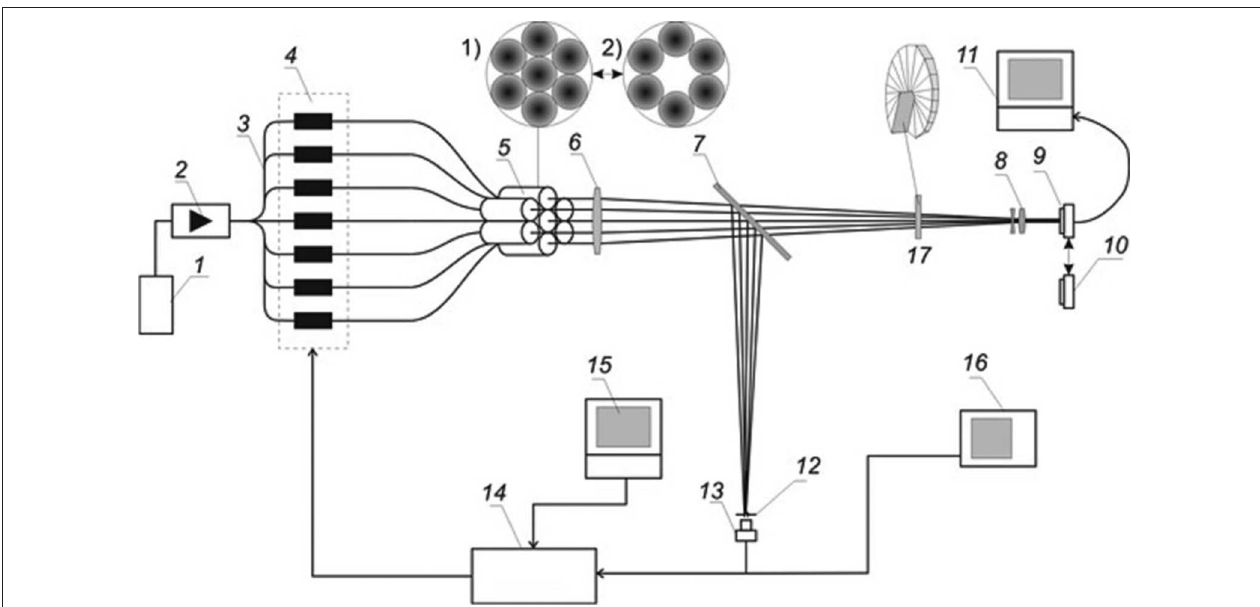
FIGURE 6 | Diagram of the experimental setup: narrowband laser (1) , optical fiber amplifier (2) , fiber splitter (3) , phase modulators (4) , fiber collimators (5) , long-focus lens (6) , beam splitting plate (7) , lenslet (8) , beam profiler (9) , Shack–Hartmann sensor (10) , computer (11) , pinhole (12) , broadband photodetector (13) , optimizing multichannel SPGD processor (14) , control computer (15) , oscilloscope (16) , spiral phase plate (17) . Arrangement of subapertures for coherent beam combining: 1) in the experiment on synthesis of a beam with maximal intensity at the axis, 2) in the experiment on synthesis of a vortex beam